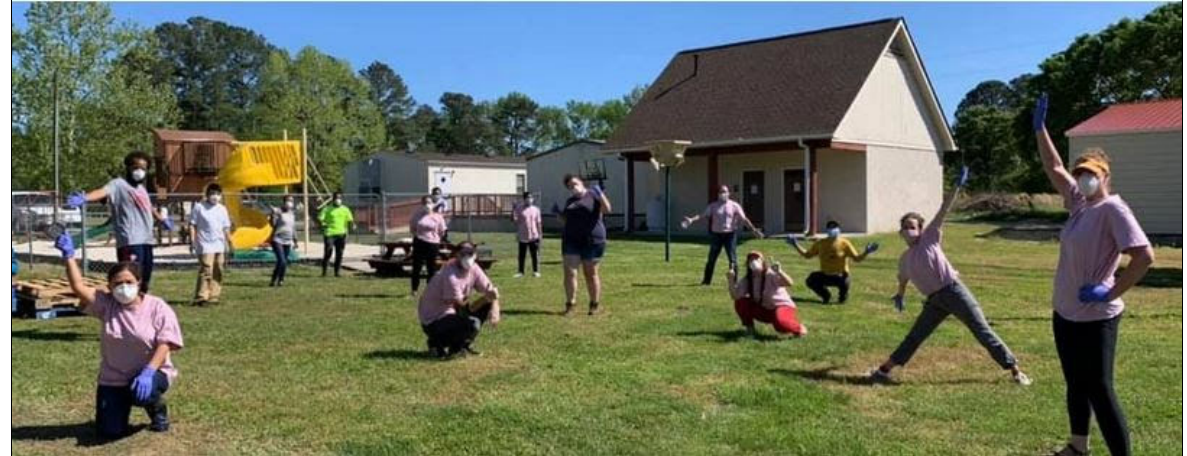
Photo courtesy of Episcopal Farmworker